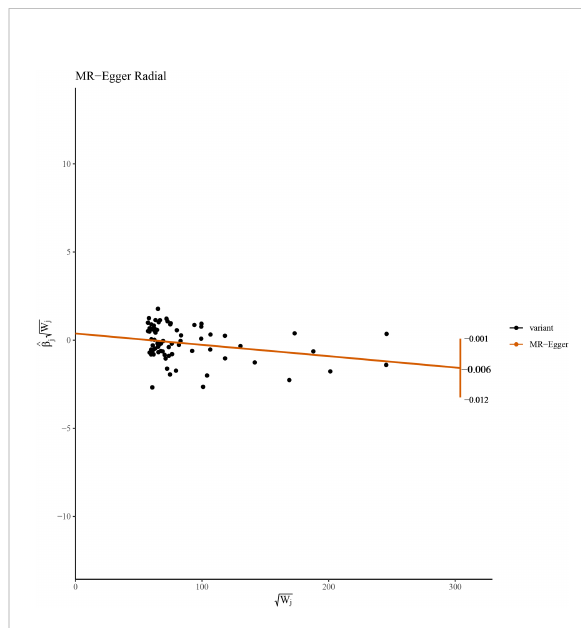
FIGURE 5 Radial plots of the MR − Egger test analyzed the outlier